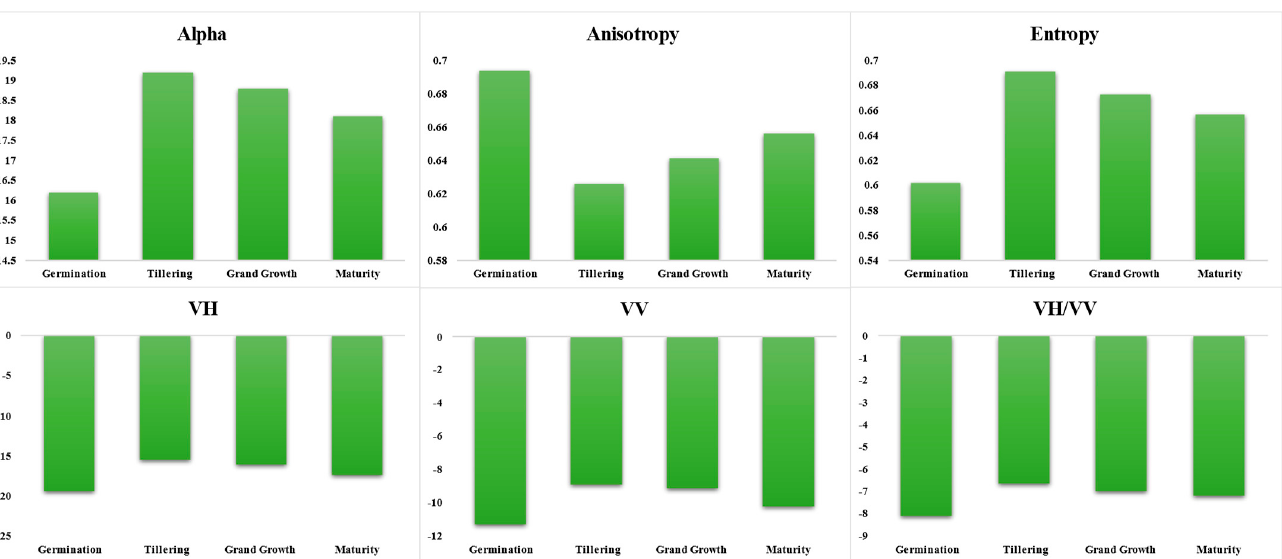
Figure 5. Temporal profile of Sentinel-2 indices.